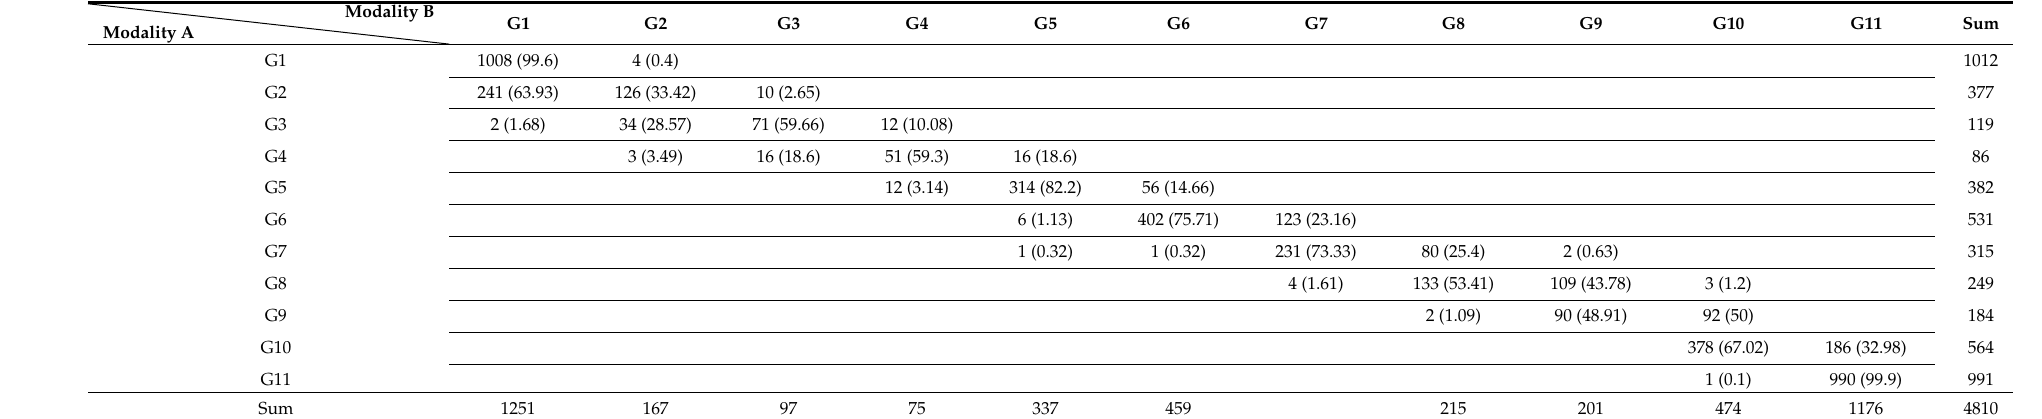
Table 2. Analysis of the agreement between two PSA assay